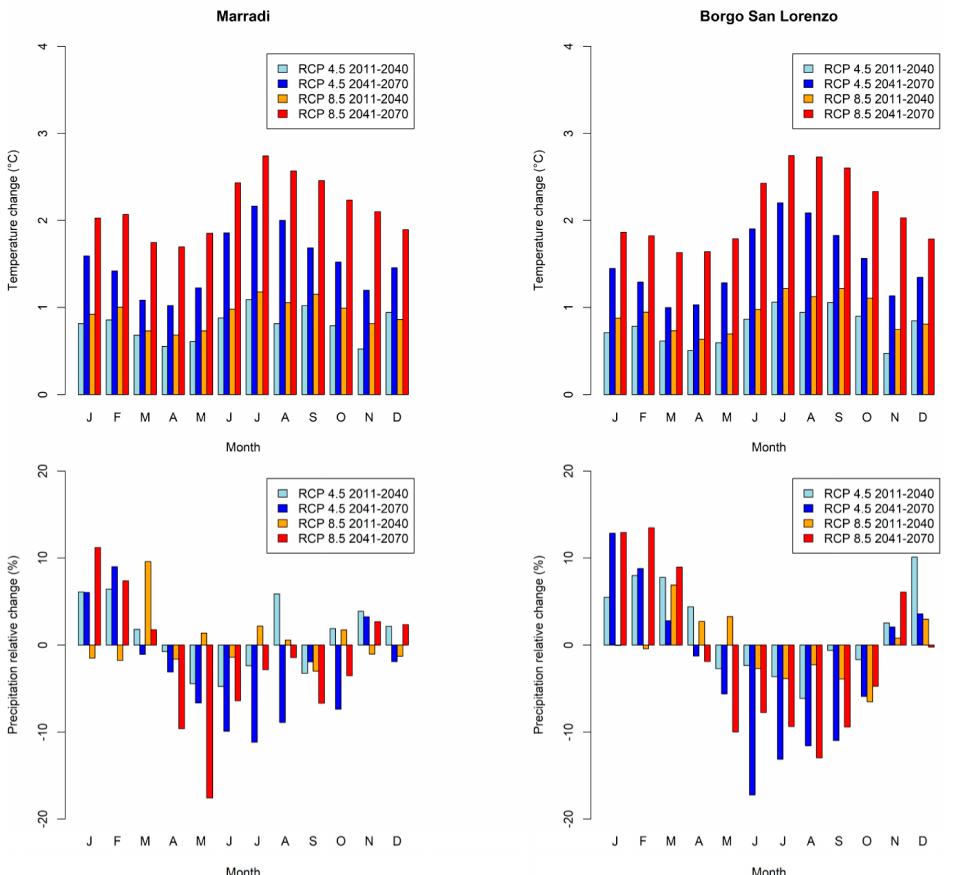
Figure 3. Absolute change (°C) in monthly mean air temperature (top graphs) and relative change (%) of monthly cumulated rainfall (bottom graphs) generated in the two study sites with the RCM ensemble (14 models) for two climate scenarios (RCP4.5, RCP8.5) and two periods – 2011–2040 (ongoing) and 2041–2070 (mid-future)—over the baseline period 1981–2010 (near past).